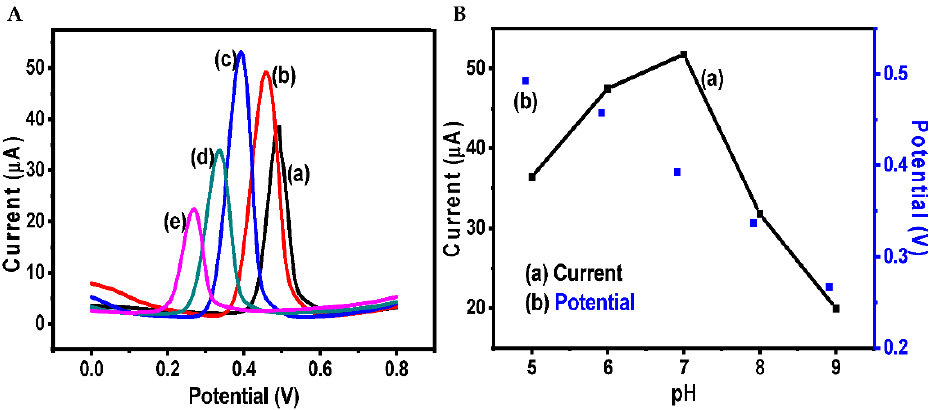
Figure 5. Effect of pH on the electrooxidation of PC on ERGO-SbNPs-PGE; DPV responses ( A ) of different pH values; 5.0 (a), 6.0 (b), 7.0 (c), 8.0 (d), and 9.0 (e). Linear plots of peak current (a) and potential (b) as a function of pH in ( B ) in 0.1 mol·L -l phosphate buffer solution containing 10 µmol·L −1 PC in solution at various pH values.